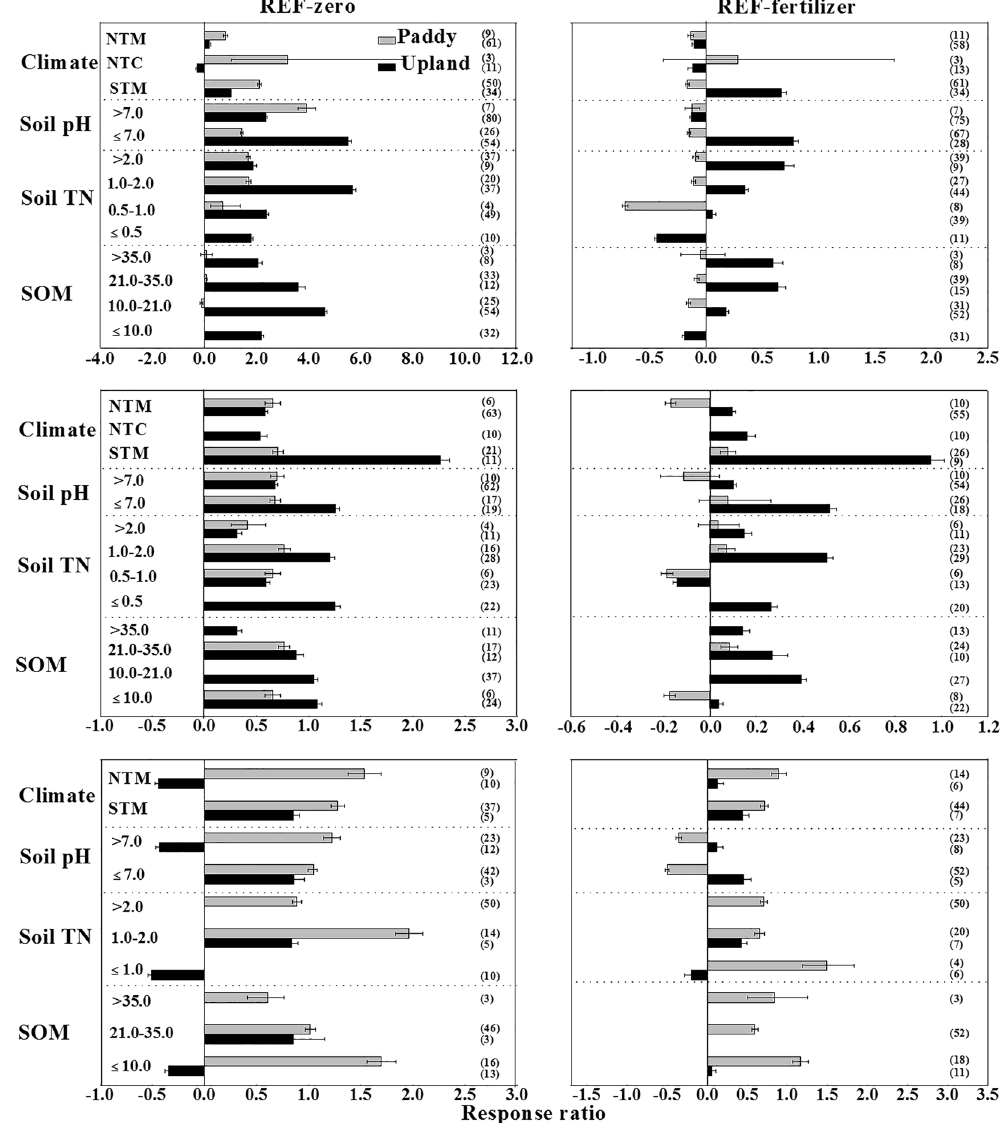
Figure 5. N 2 O, CO 2 and CH 4 emissions (CH 4 emission for paddies and uptake for upland) affected by Org-M compared to Non-F ( a , c , e ) and Min-F ( b , d , f ). The influence factors included climate types, soil pH, SOM and TN content. NTM means temperate monsoon climate; NTC means temperate continental climate; STM means subtropical monsoon climate. Numbers near right border are the numbers of comparisons. P < 0.05 when error bars do not overlap